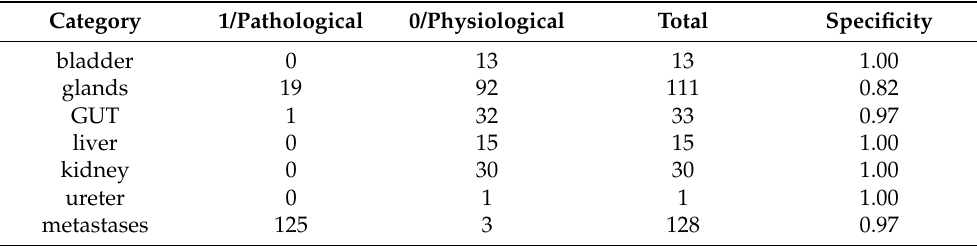
Table 6. The results of the predictions on the test cohort. (GUT: gastrointestinal tract).